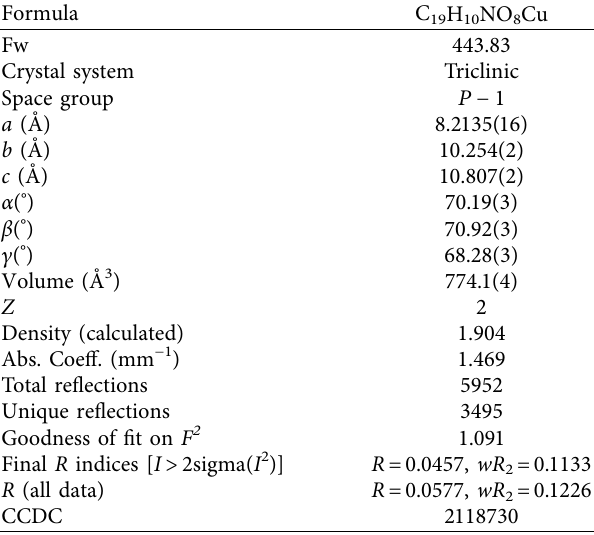
Table 1: Crystal parameters and specific details of complex 1